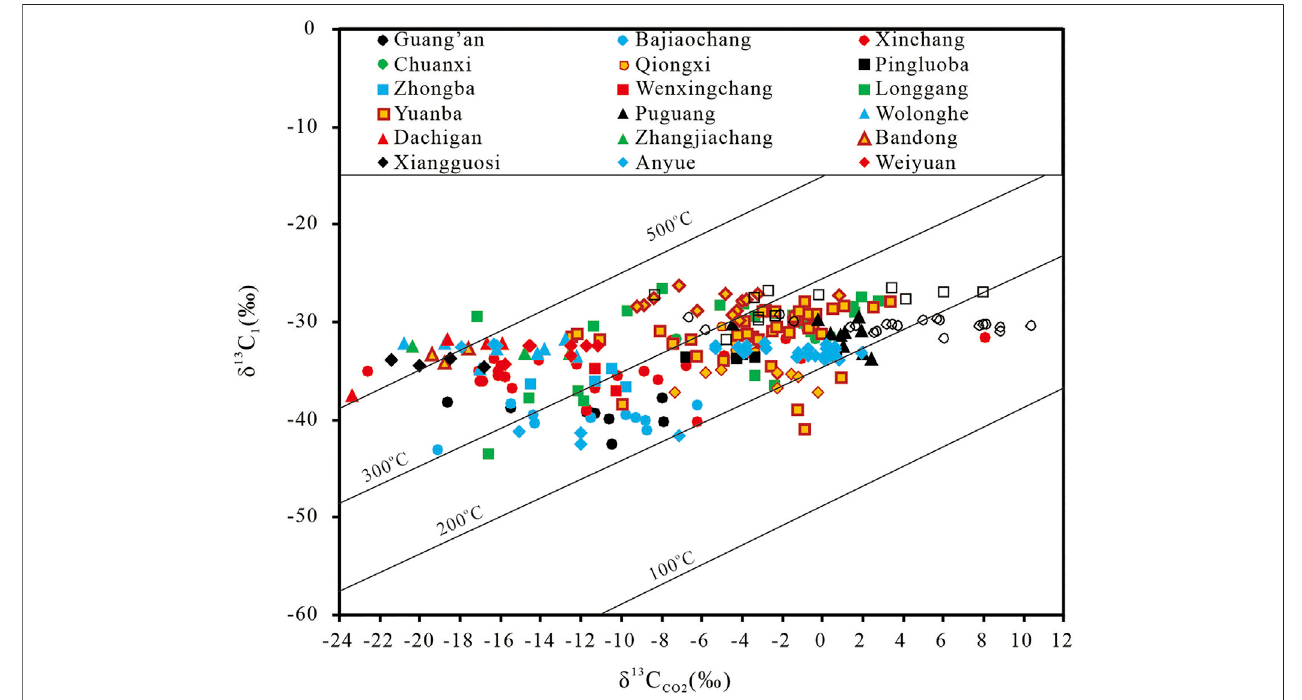
FIGURE 10 | Plot of δ 13 C values of CO 2 and coexisting CH 4 . Isotherms for hypothetical isotopic equilibrium are from Richet et al. (1977).